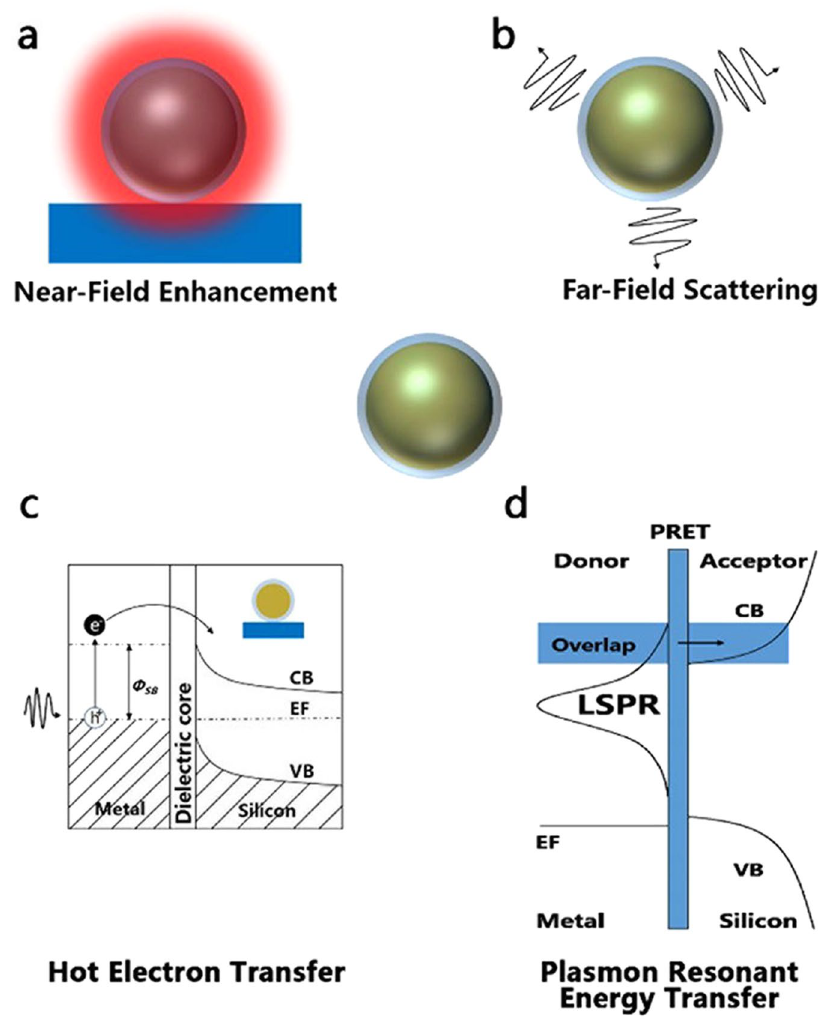
Figure 1. Four possible photophysical processes of core-shell nanoparticle in contact with Si solar cells. ( a ) Near-field coupling. ( b ) Far-field scattering. ( c ) Hot electron transfer. ( d ) Plasmon resonant energy